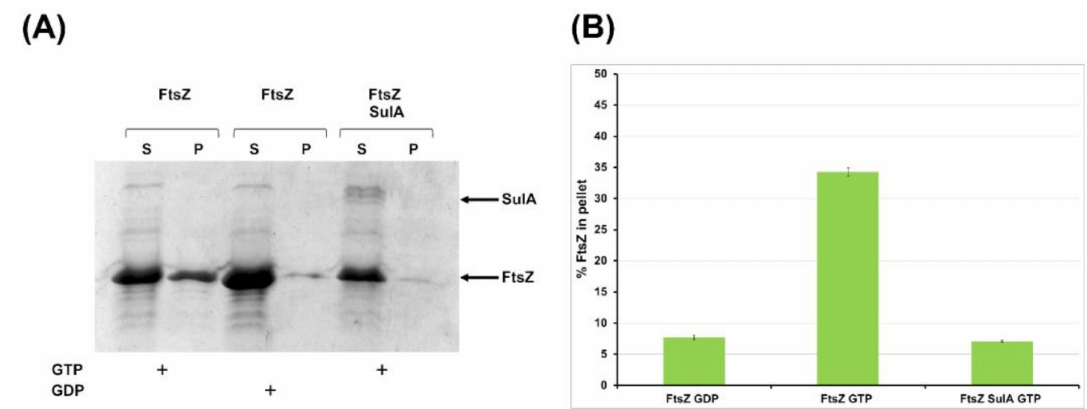
Figure 6. E ff ect of B. cenocepacia SulA on FtsZ in vitro polymerization. FtsZ was induced to polymerize in the presence or absence of SulA. ( A ) The polymeric FtsZ was collected by sedimentation and the amount of FtsZ in the pellets (P) was estimated by coomassie-blue staining of the SDS-PAGE. S, supernatant. ( B ) The bars indicate the relative quantification of FtsZ percentage in the pellet obtained by densitometry analysis. Data are the average ± SD of three independent experiments.